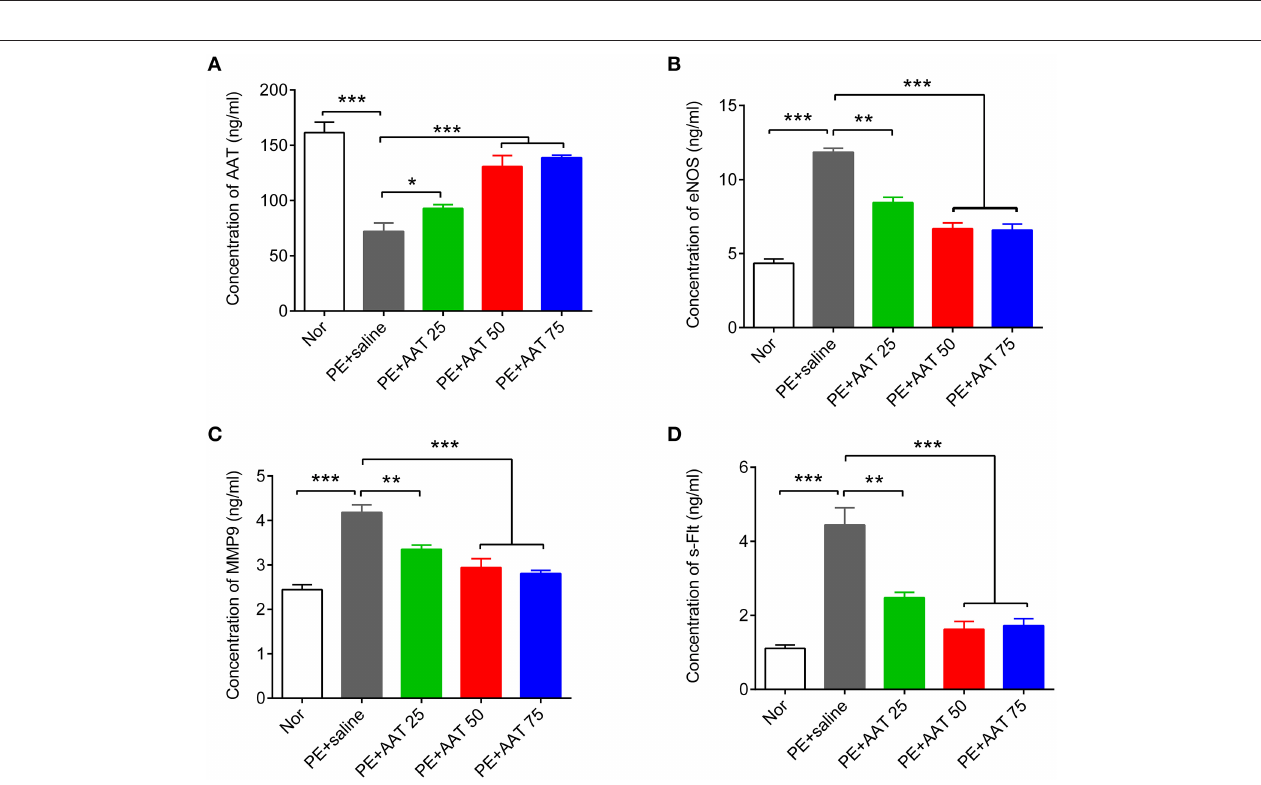
FIGURE 2 | AAT decreases the concentration of eNOS, MMP9, and s-Flt in blood from PE animals. ELISA was used to detect the concentration of AAT (A) , eNOS (B) , MMP9 (C) , and s-Flt (D) in serum from PE or normal animals after indicated treatment. N = 8 . * p < 0.05 , ** p < 0.01 , *** p < 0.001